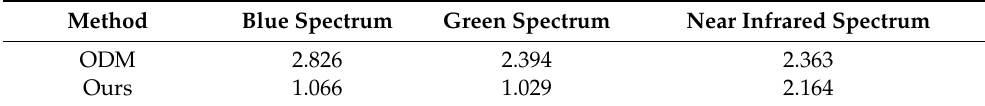
Table 7. RMSE values of ODM and our methods on BGNIR multispectral aerial image mosaic.